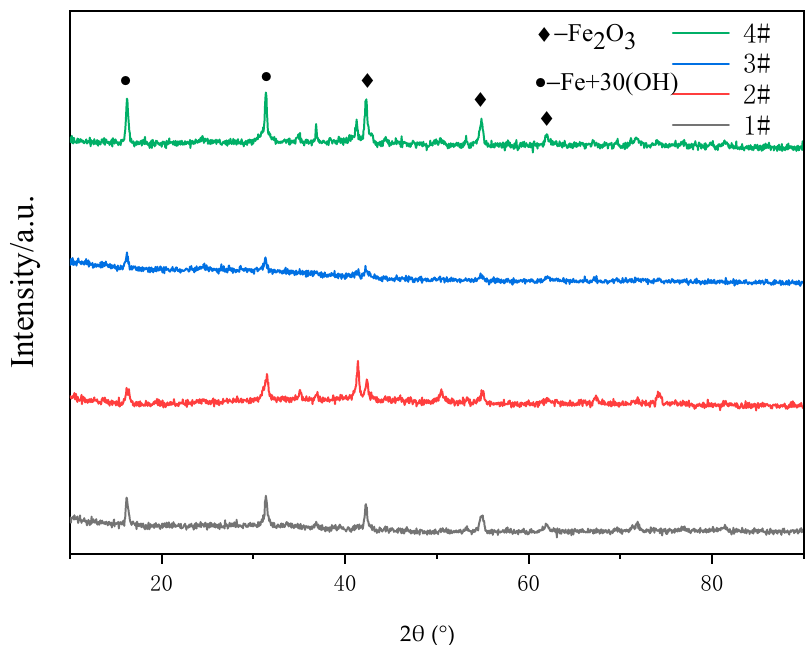
Figure 9. XRD patterns of different coatings after salt spray test. Table 5. Atomic percentage content measured by EDS.